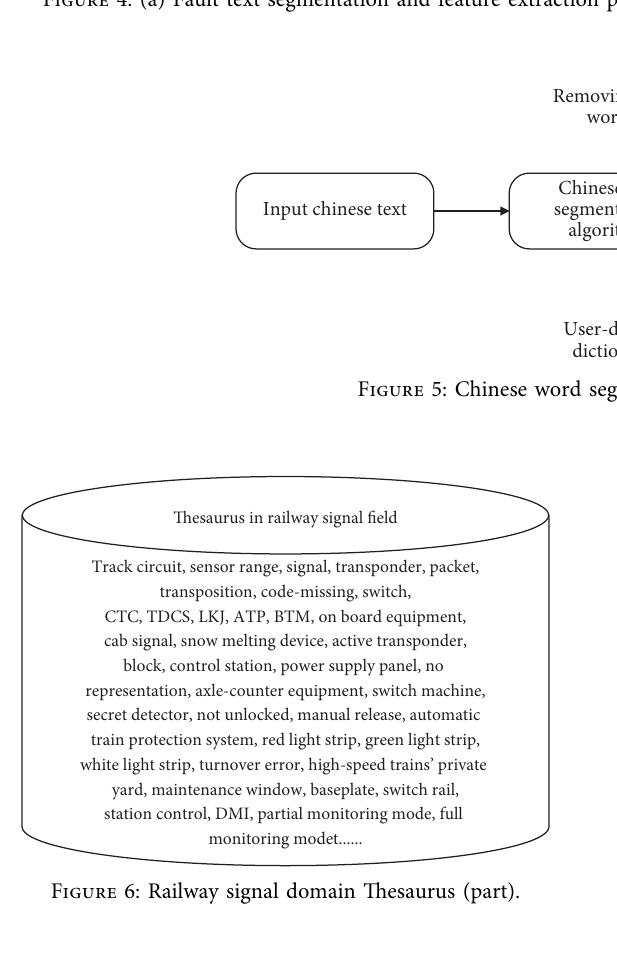
Figure 4: (a) Fault text segmentation and feature extraction process; (b) Feature extraction process based on topic model.